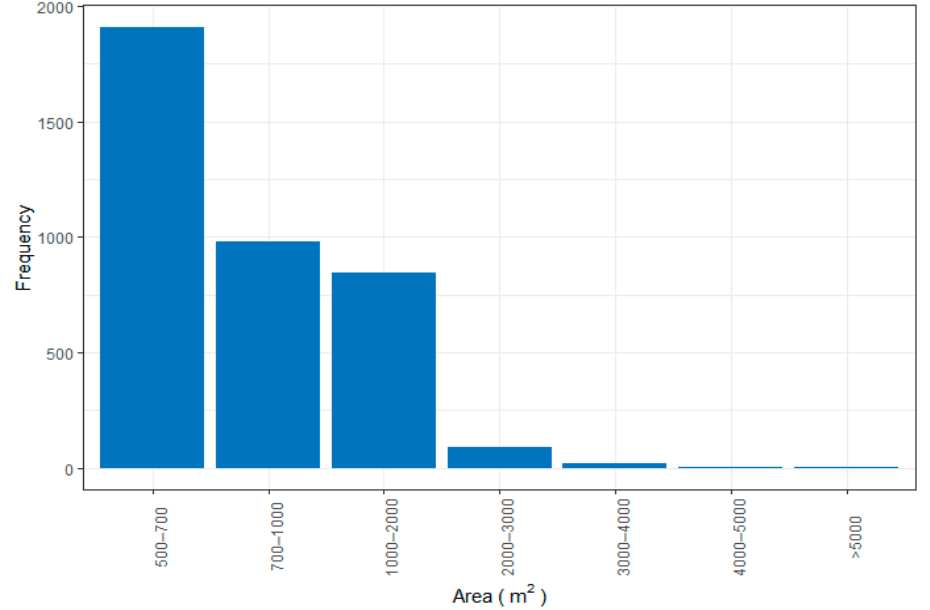
Figure 5. Frequency distribution of the size of polygons assigned to the “mixed forest” class.